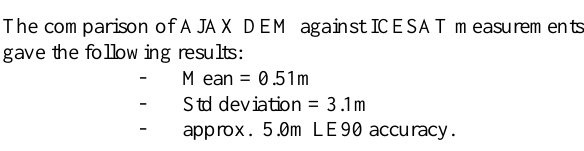
Figure 6 – Histogram (in %) of the elevation differences against ICESAT (in meters).